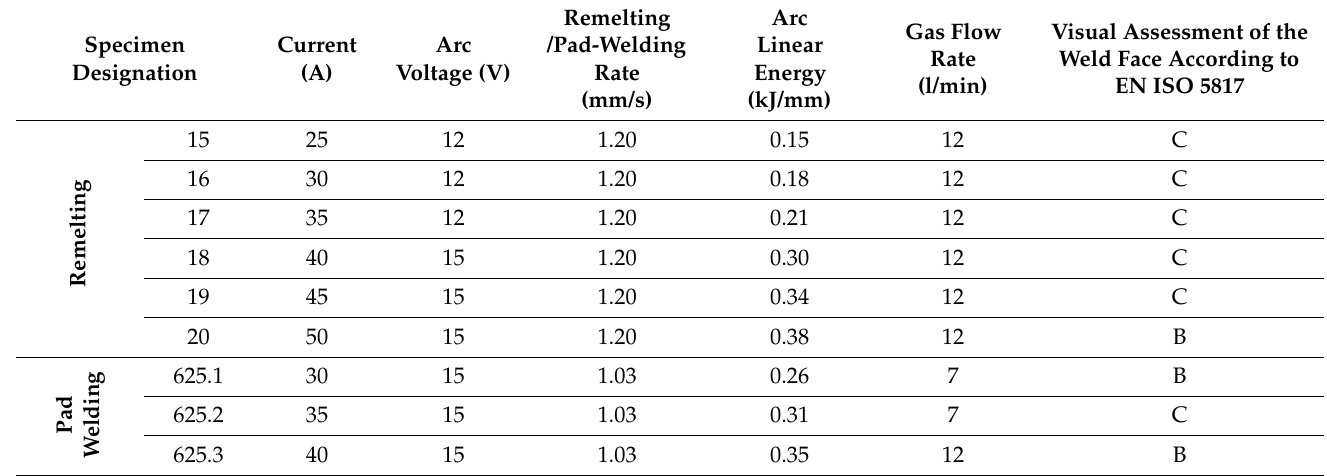
Table 2. Parameters of the Tungsten Inert Gas remelting and pad-welding processes in an argon